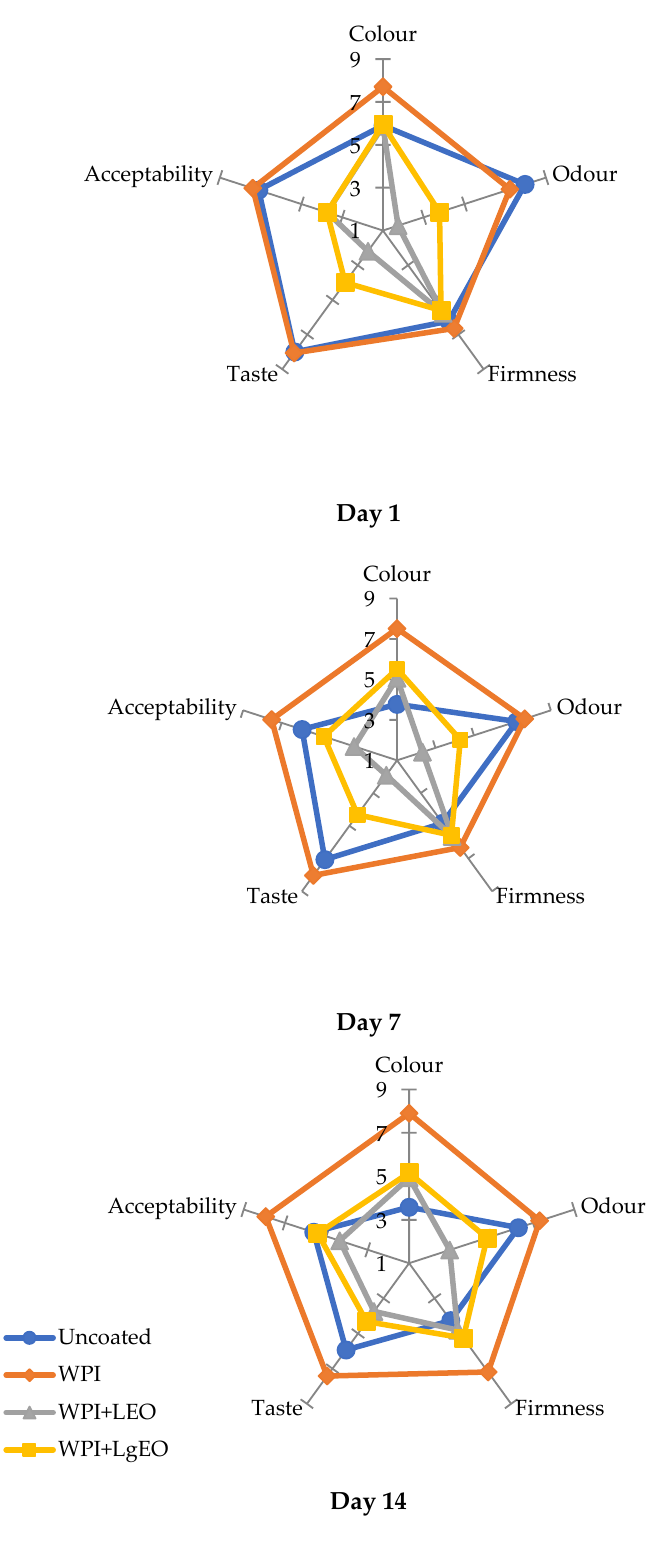
Figure 7. Sensory attributes of fresh-cut pears coated with whey protein isolate coatings (WPI) incorporated with lemon (WPI + LEO) and lemongrass (WPI + LgEO) essential oils or uncoated samples during storage at 4 °C.